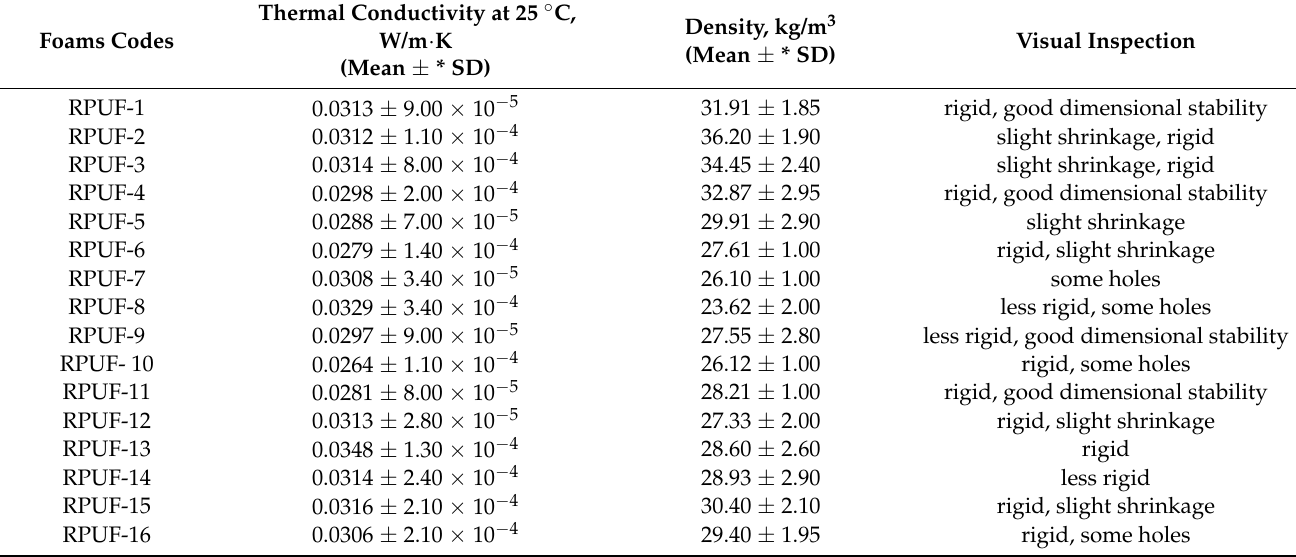
Table 2. Experimental data for the 16 foams